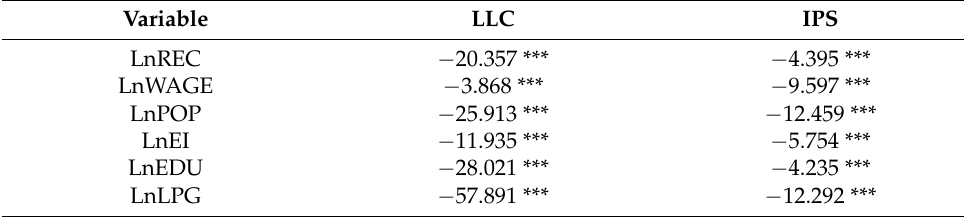
Table 4. Results of the unit root test for all variables.